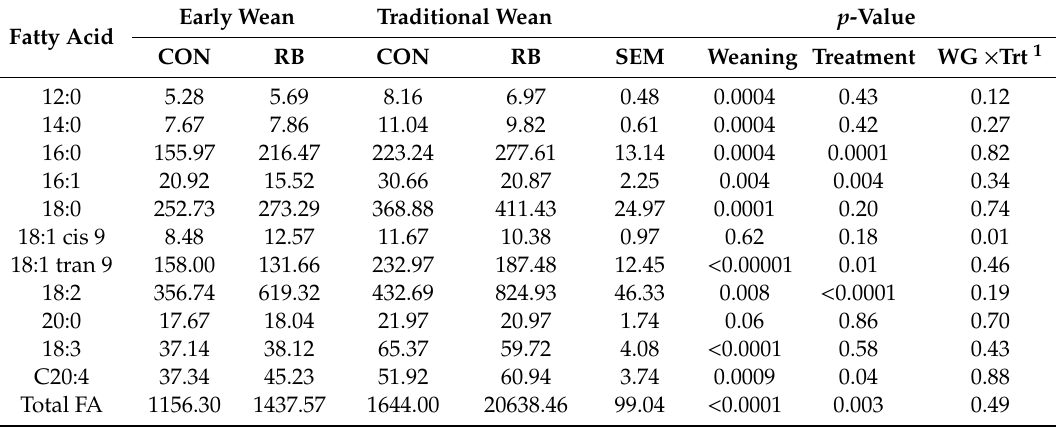
Table 5. Specific and total serum fatty acids (mg / mL) on d 90 of steers that were early weaned at 150 d of age (n = 12) or traditionally weaned at 210 d of age (n = 12) and then supplemented with a rumen by-pass lipid ration (RBL) or an isocaloric, isonitrogenous control diet